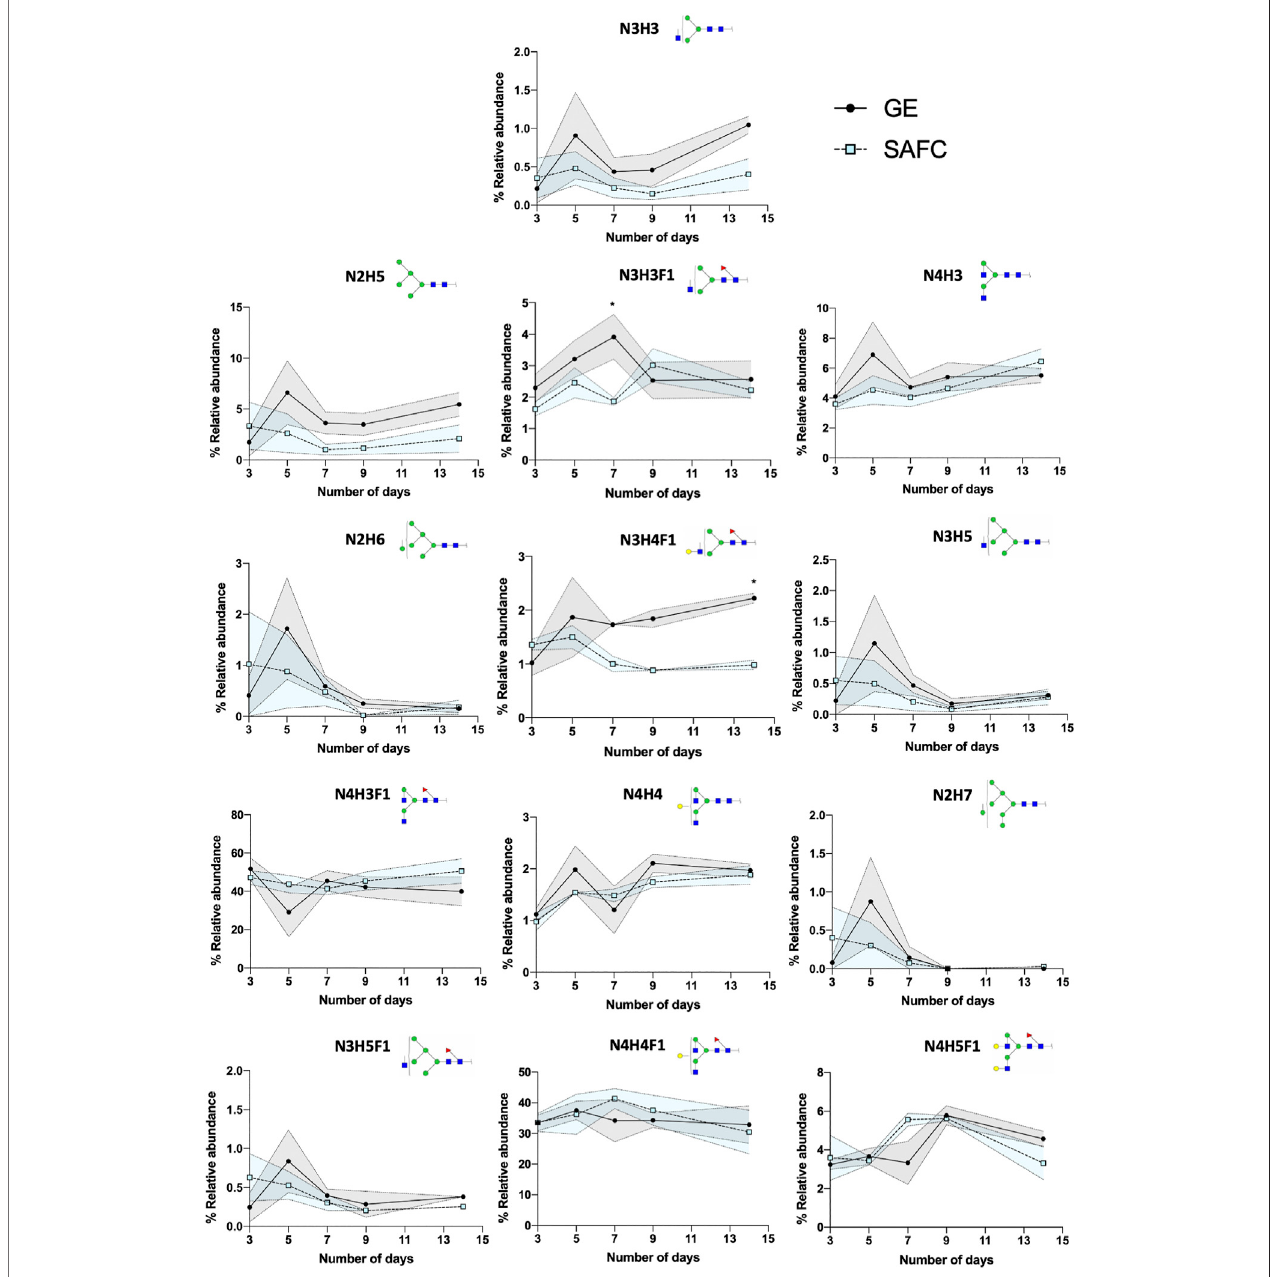
FIGURE 7 | The relative abundance of in-house produced trastuzumab biosimilar glycoforms cultured in GE or SAFC media and on different length of duration. (Two-wayANOVAfollowedbyBonferroni ’ sposthoctest,multiplecomparisonswereperformedbetweenGEandSAFCmedia, n (cid:2) 3;* p < 0.05;shaded areadenotes ± 1 standard